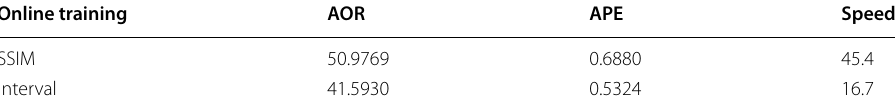
Table 5 Success and precision plots on OTB2013 datasets with different online training methods Online